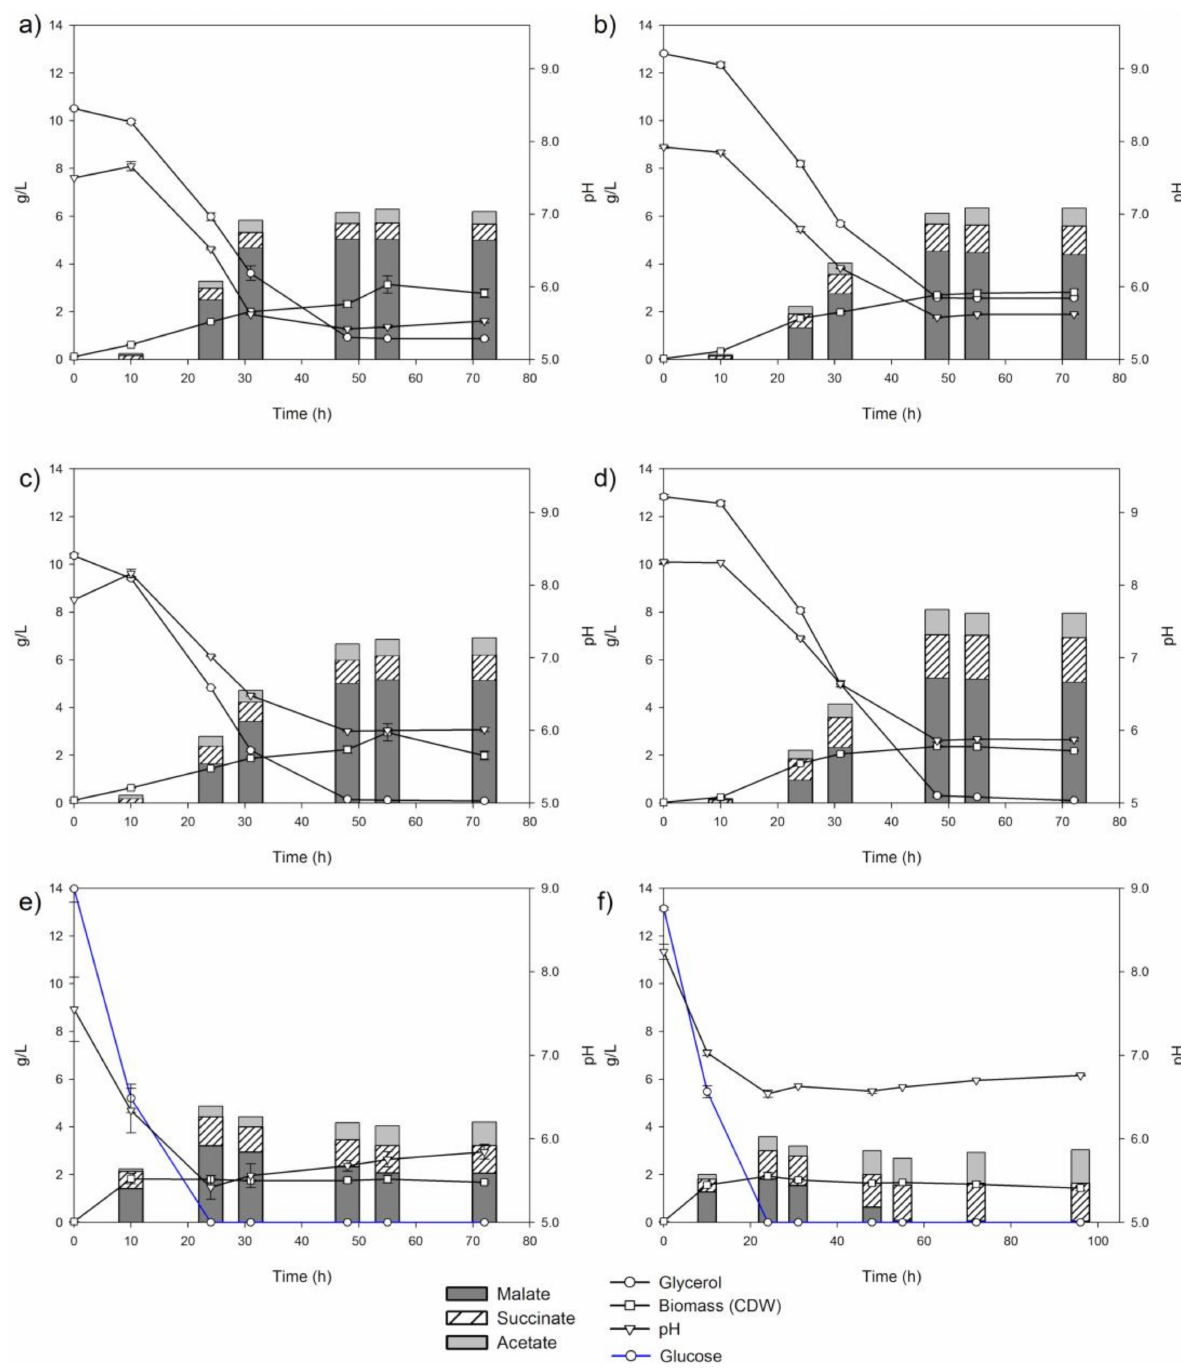
Figure 4. Bicarbonate and glycerol assays with several initial concentrations: 2 g/L of bicarbonate and 10 g/L of glycerol ( a ); 2 g/L of bicarbonate and 12.5 g/L of glycerol ( b ); 4 g/L of bicarbonate and 10 g/L of glycerol ( c ); 4 g/L of bicarbonate and 12.5 g/L of glycerol ( d ); 13 g/L of glucose with 2 g/L of bicarbonate ( e ); and 13 g/L of glucose with 4 g/L of bicarbonate ( f ). Standard deviation of succinic acid, malic acid and acetic acid are shown in Table